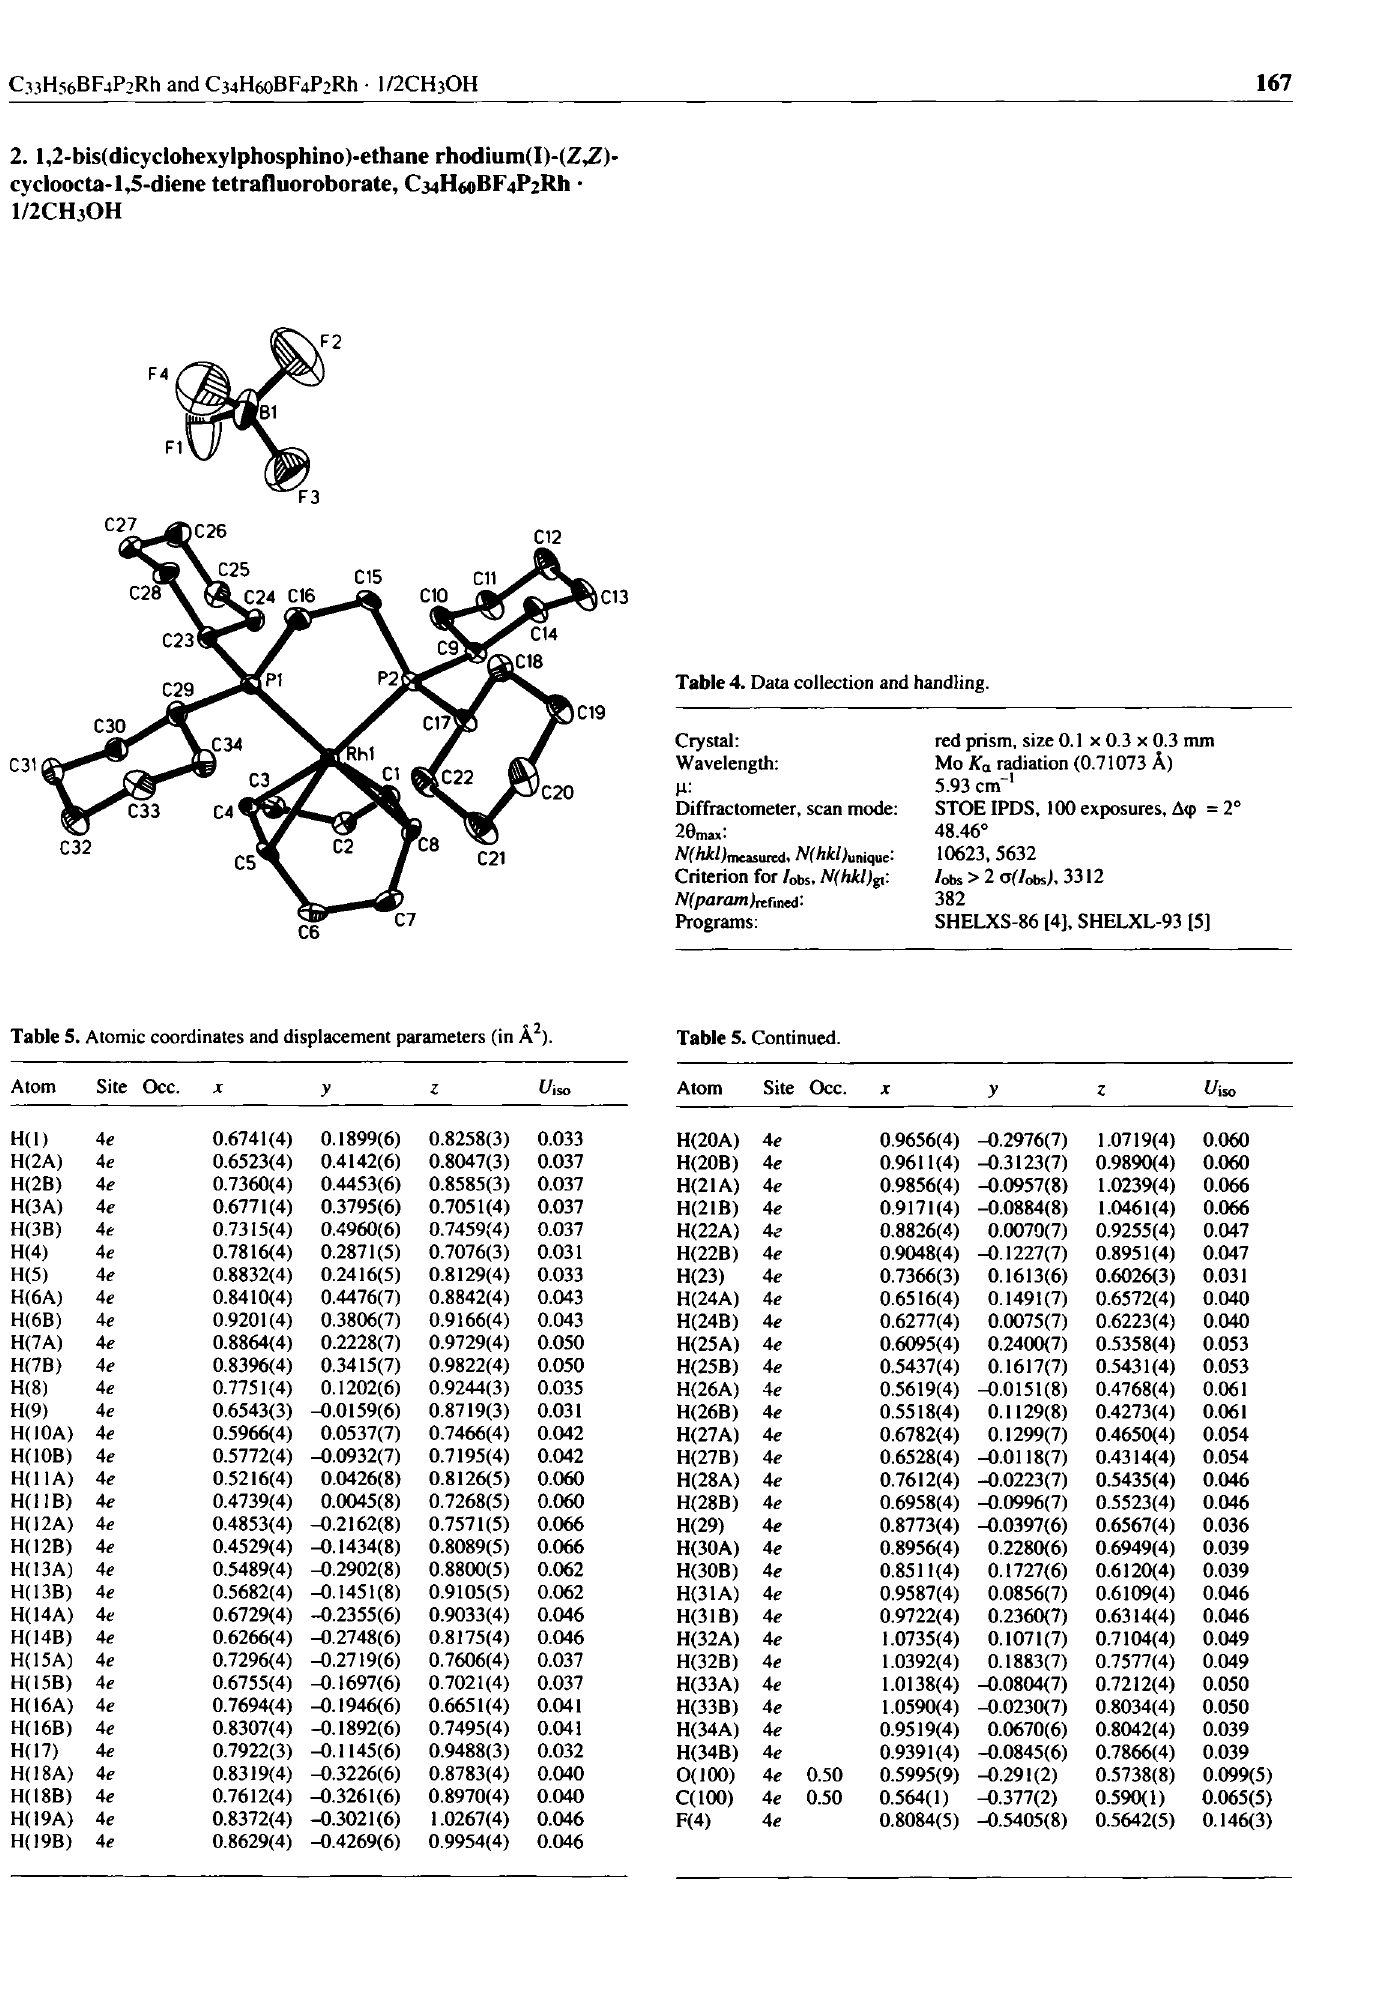
Table 5. Atomic coordinates and displacement parameters (in A 2 ). Table 5.